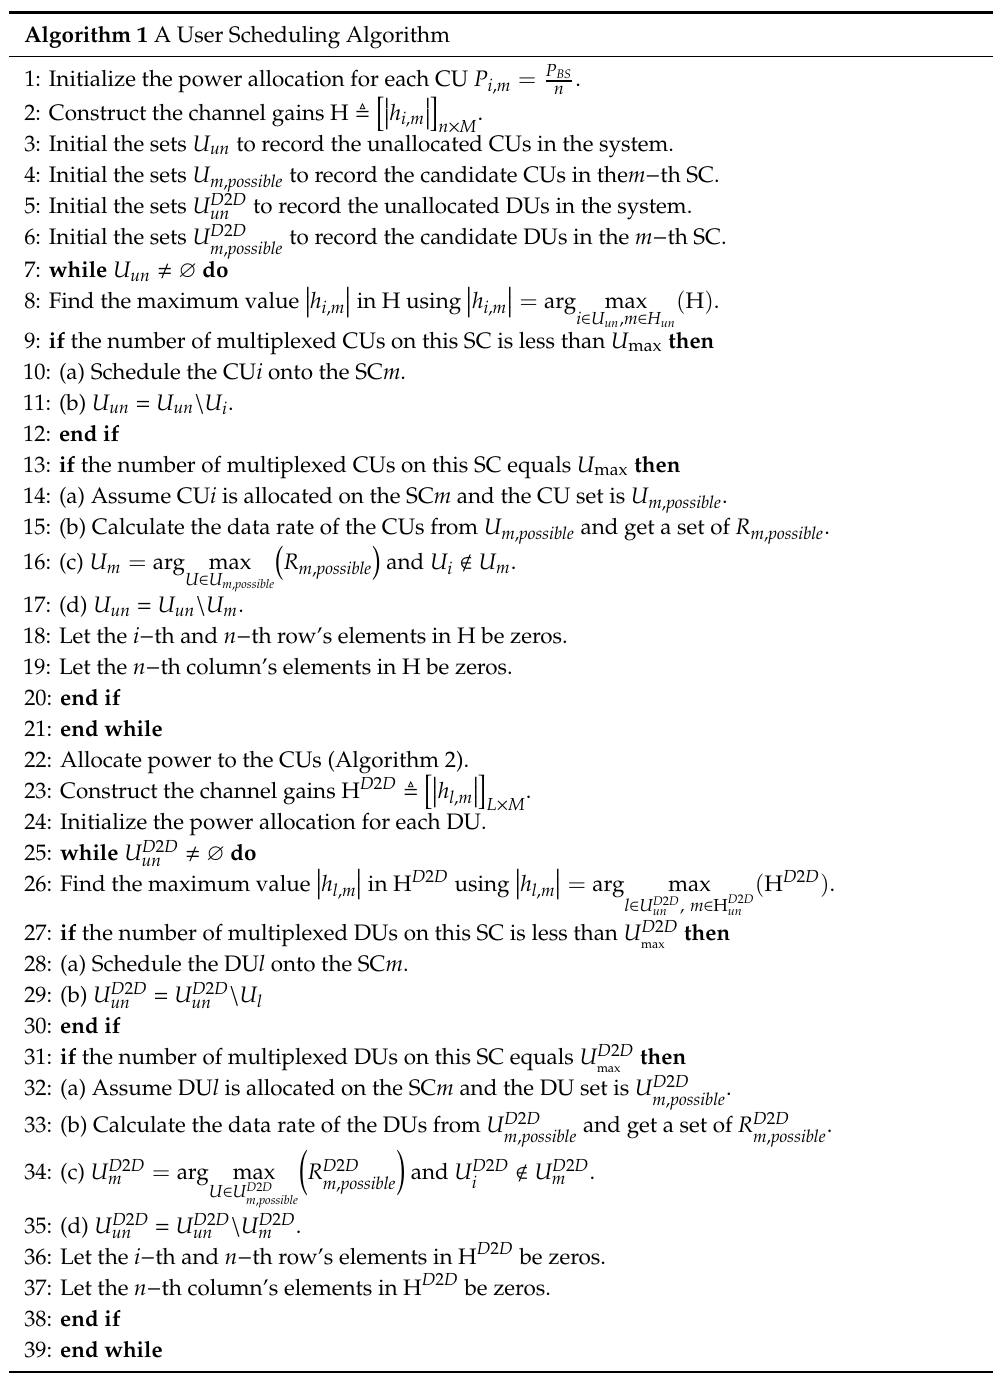
Algorithm 1 A User Scheduling